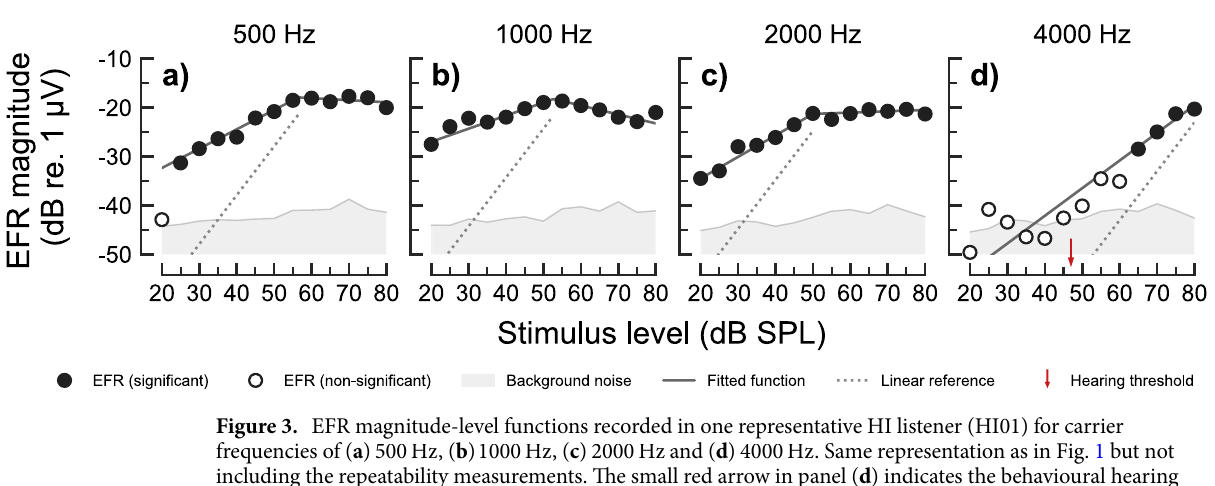
Figure 3. EFR magnitude-level functions recorded in one representative HI listener (HI01) for carrier frequencies of ( a ) 500 Hz , ( b ) 1000 Hz , ( c ) 2000 Hz and ( d ) 4000 Hz . Same representation as in Fig. 1 but not including the repeatability measurements. The small red arrow in panel ( d ) indicates the behavioural hearing threshold of the listener at 4000 Hz in dB